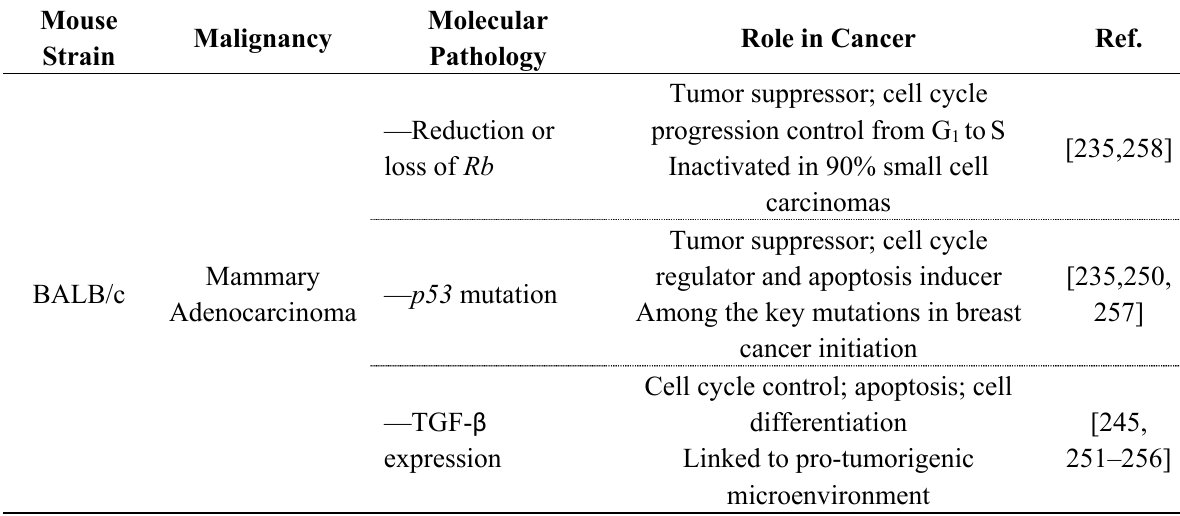
Table 7. Molecular pathologies associated with radiation-induced breast